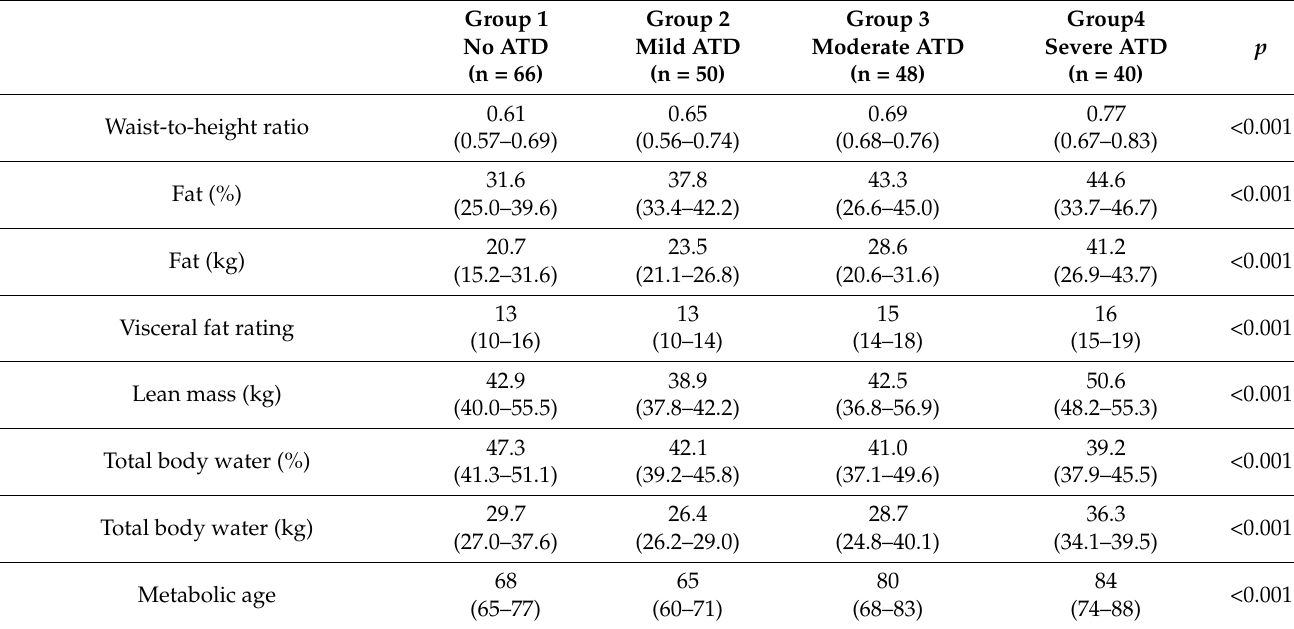
Table 5. Receiver-operating characteristics (ROC) curves identifying discrimination thresholds of BAI and BMI for VAI- defined adipose tissue dysfunction (ATD).